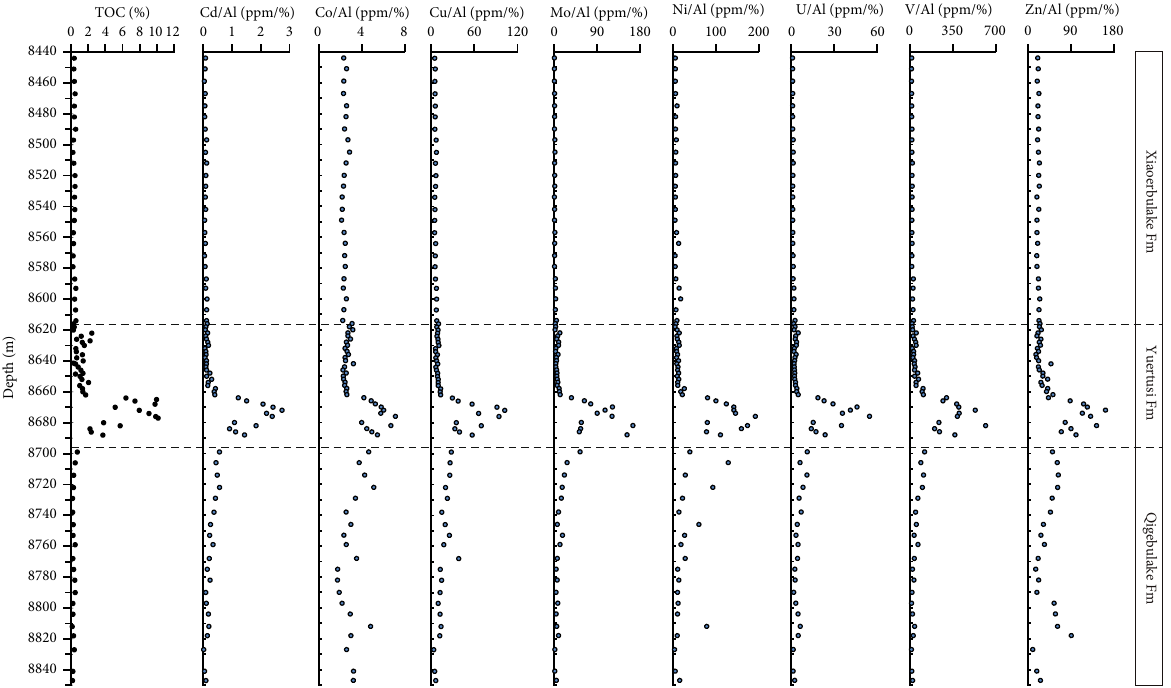
Figure 3: Pro fi les of TOC, Cd/Al, Co/Al, Cu/Al, Mo/Al, Ni/Al, U/Al, V/Al, and Zn/Al in well Luntan